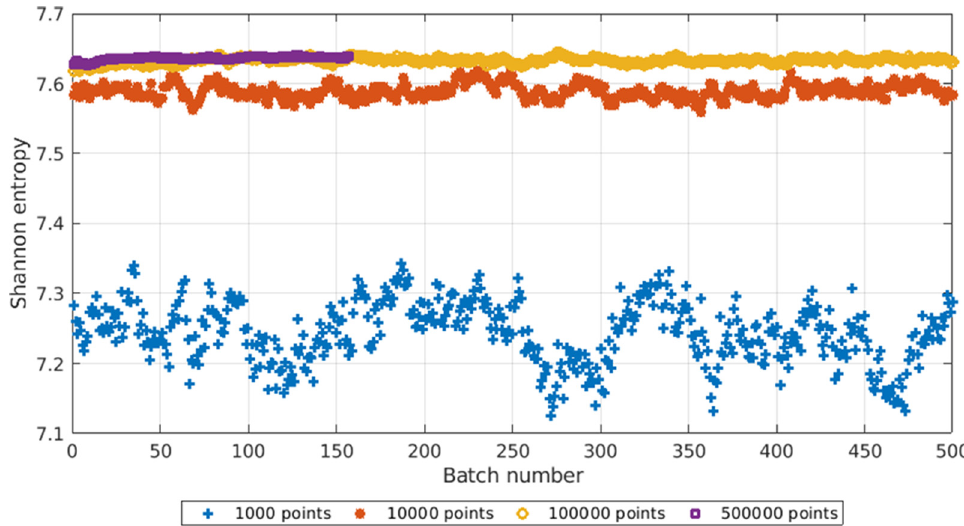
Fig. 7. Shannon entropy computed during the calculation of each